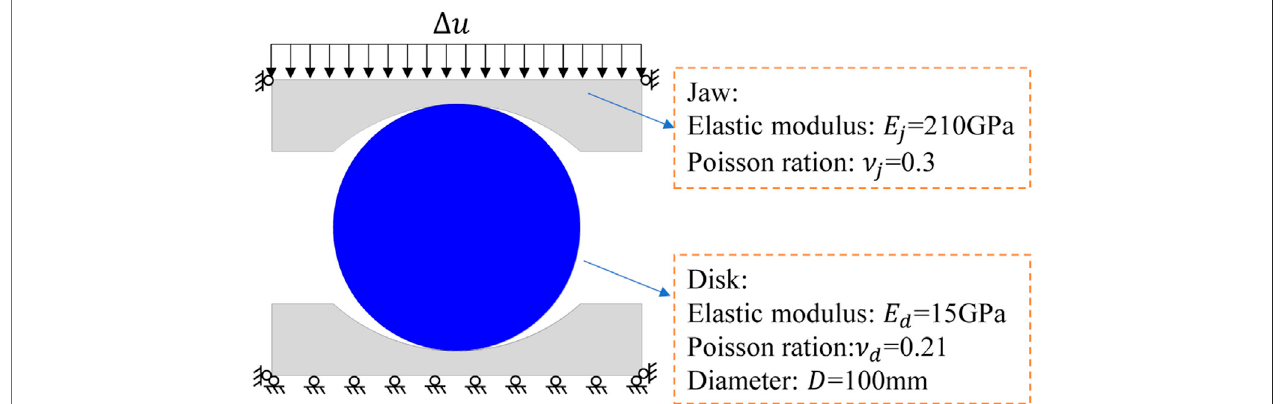
FIGURE 2 | 2D Brazilian test sample and boundary constraint.